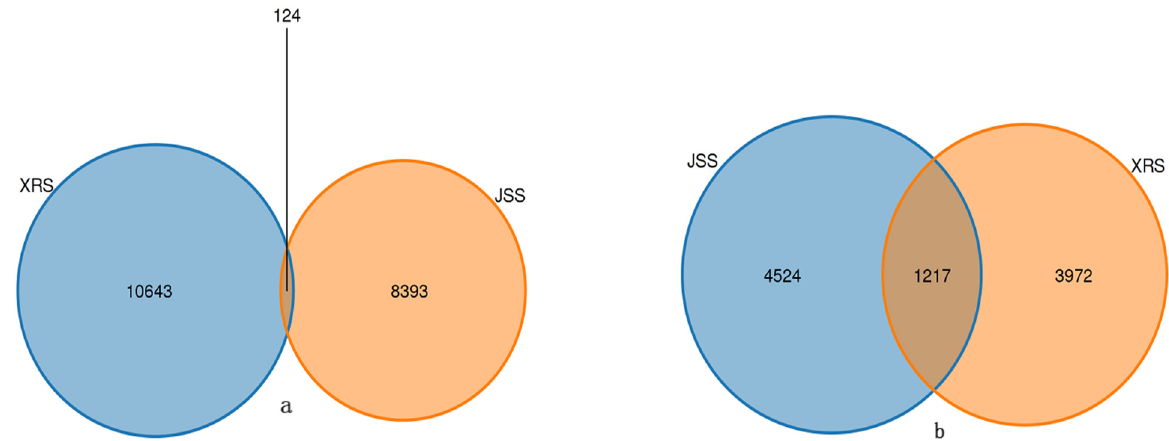
Figure 6. Venn diagrams depicting the number of shared and unique ( a ) bacterial and ( b ) fungal ASVs among treatments. 124 common ASVs were identified at bacterial; 1217 common ASVs were identified at fungal. Each circle represents sampled compartments. JSS: the bulk soil sample; XRS: soil of the P. sibiricum rhizosphere.